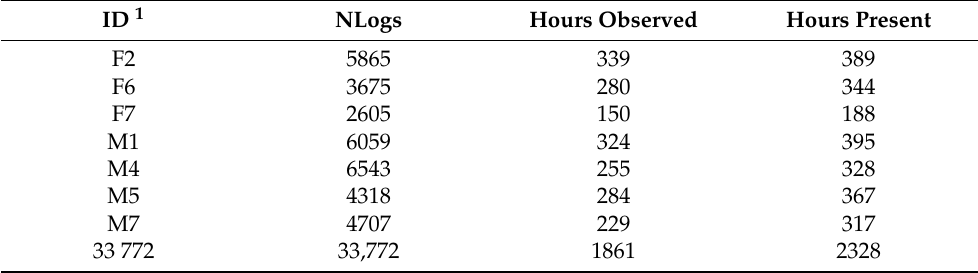
Table 1. Number of logs, hours observed, hours of human presence per individual throughout the study